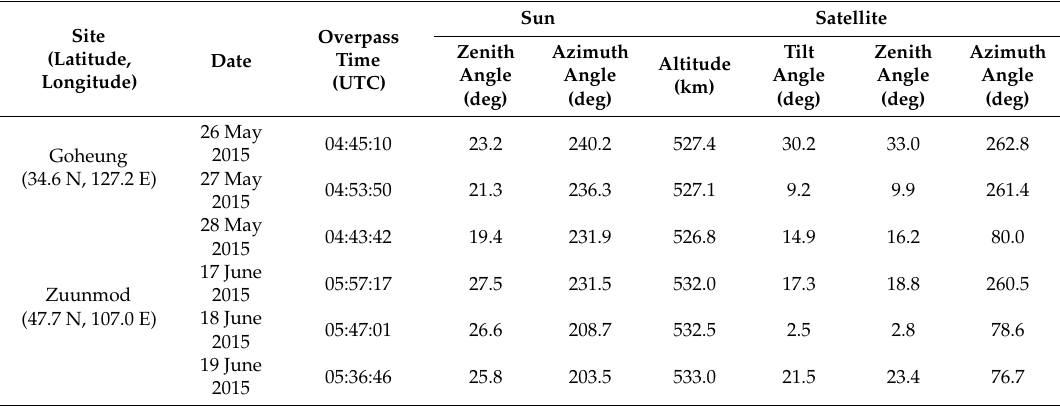
Table 1. Image list and metadata used.